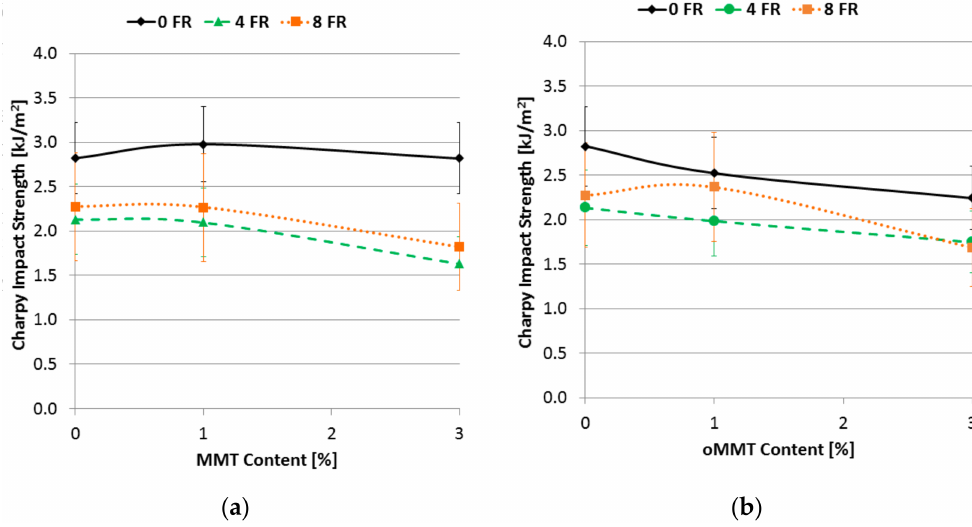
Figure 13. Charpy impact strength (notched) as a function of filler content ( a ) MMT filler; ( b ) oMMT